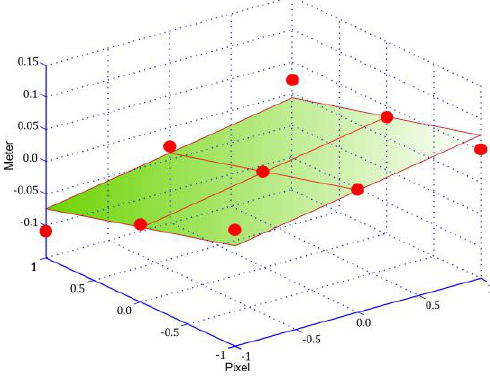
Figure 2: Best Fit Plane for 3 x 3